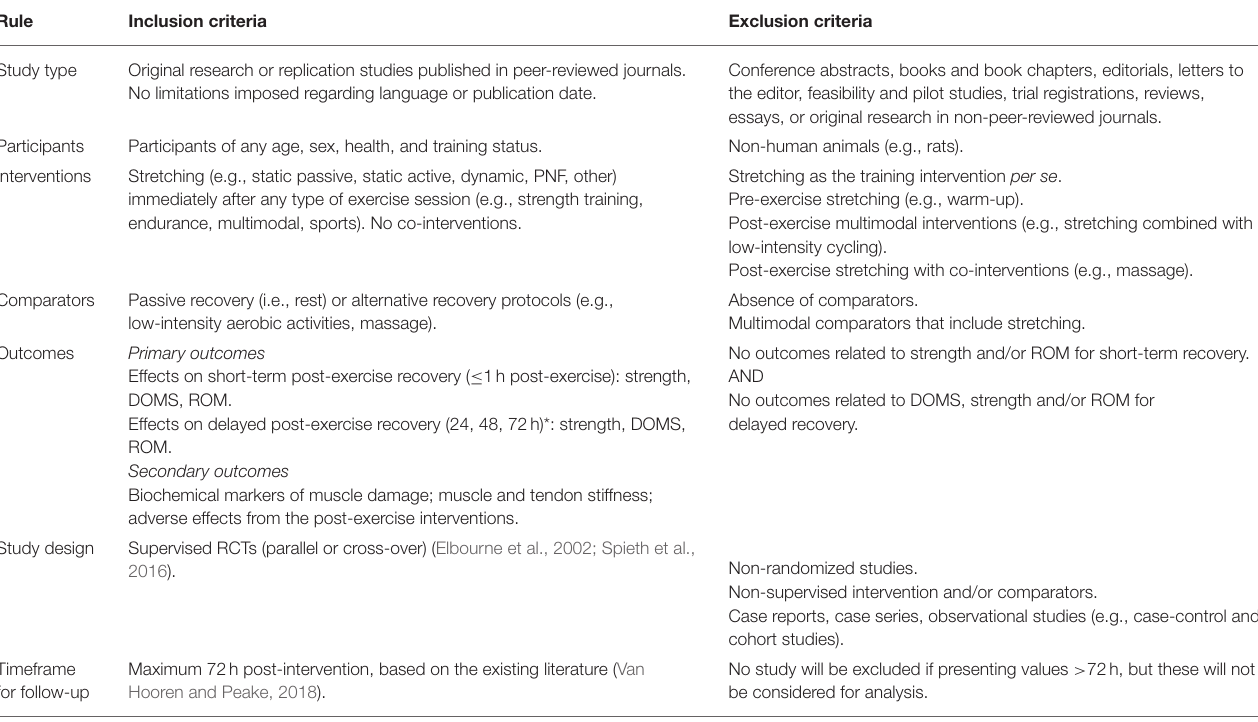
TABLE 1 | Inclusion and exclusion criteria based on scope, PICOS and timeframe for